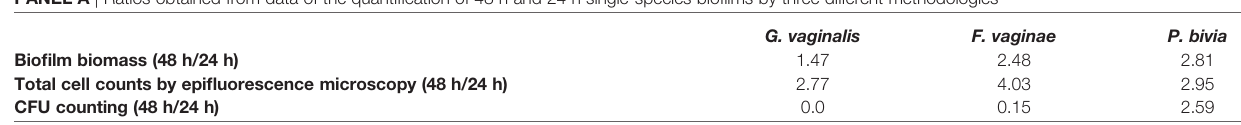
TABLE 1 | Different ratios resulted from quanti fi cation using the three different methodologies. PANEL A | Ratios obtained from data of the quanti fi cation of 48 h and 24 h single-species bio fi lms by three different